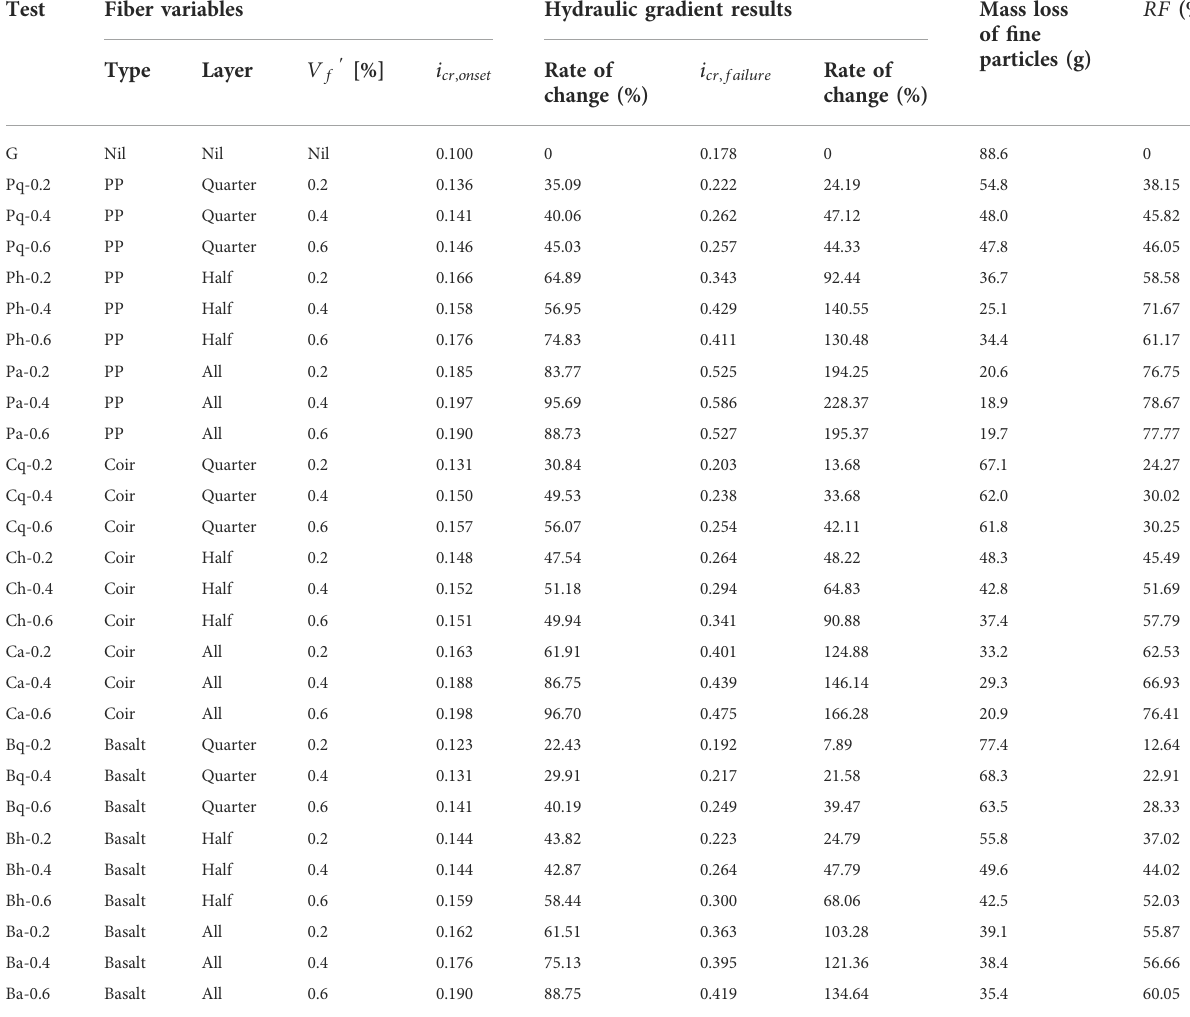
TABLE 4 Summary of test